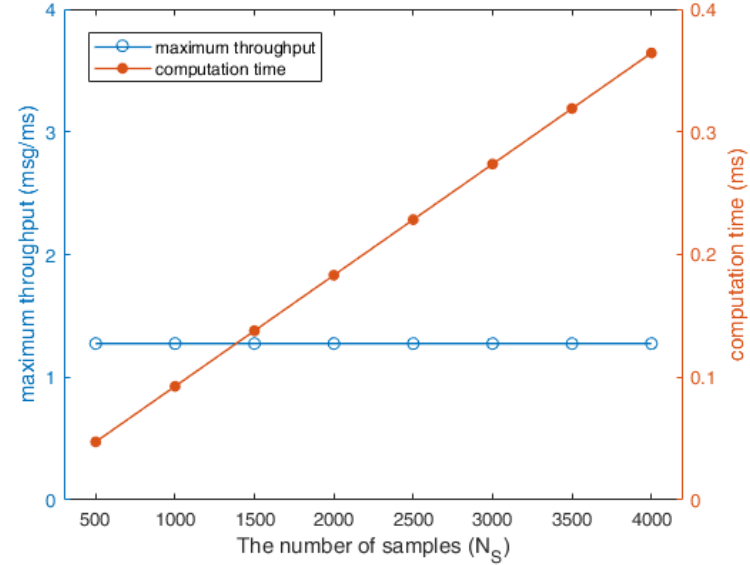
Figure 10. The maximum data throughput results and the computation times according to 𝑁 𝑆 .